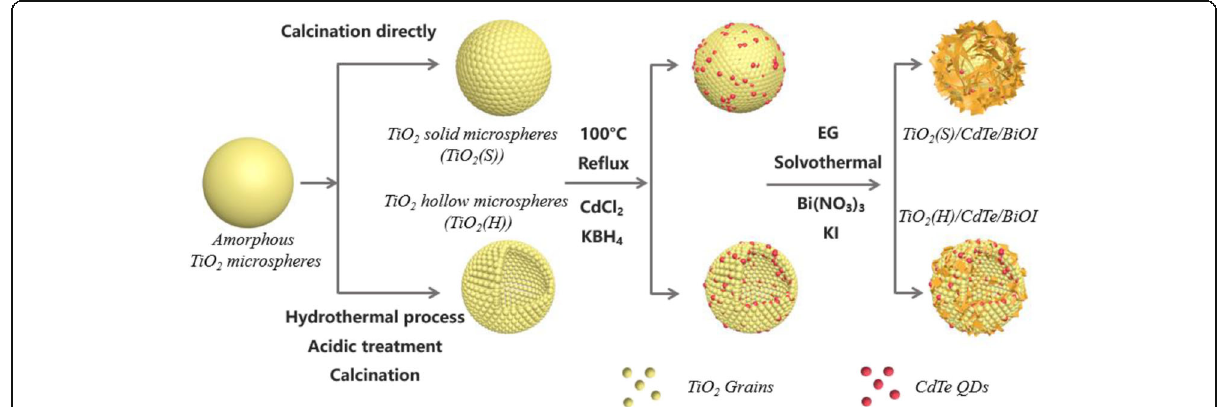
Scheme 1 Structural evolution from amorphous TiO 2 to TiO 2 /CdTe/BiOI